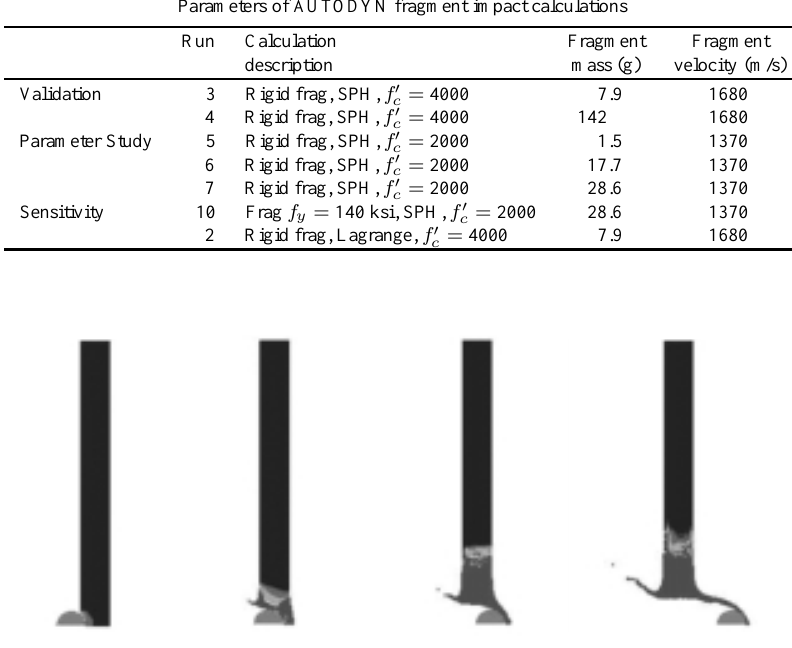
Fig. 4. Snapshots from analysis of 142 g fragment impact on CMU